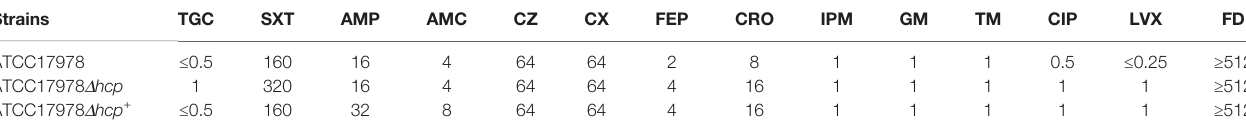
TABLE 1 | Antibiotic susceptibility test (MIC, mg/L).